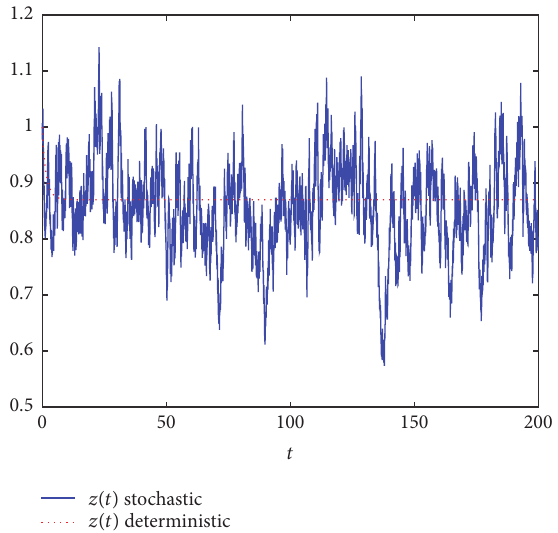
Figure 3: Solution of model (62) for 𝛾 1 (𝜃) = (1.5, 1.3, 1) . Blue: 𝜎 𝑖 = 0.1 (𝑖 = 1, 2, 3, 4, 5) . Red: 𝜎